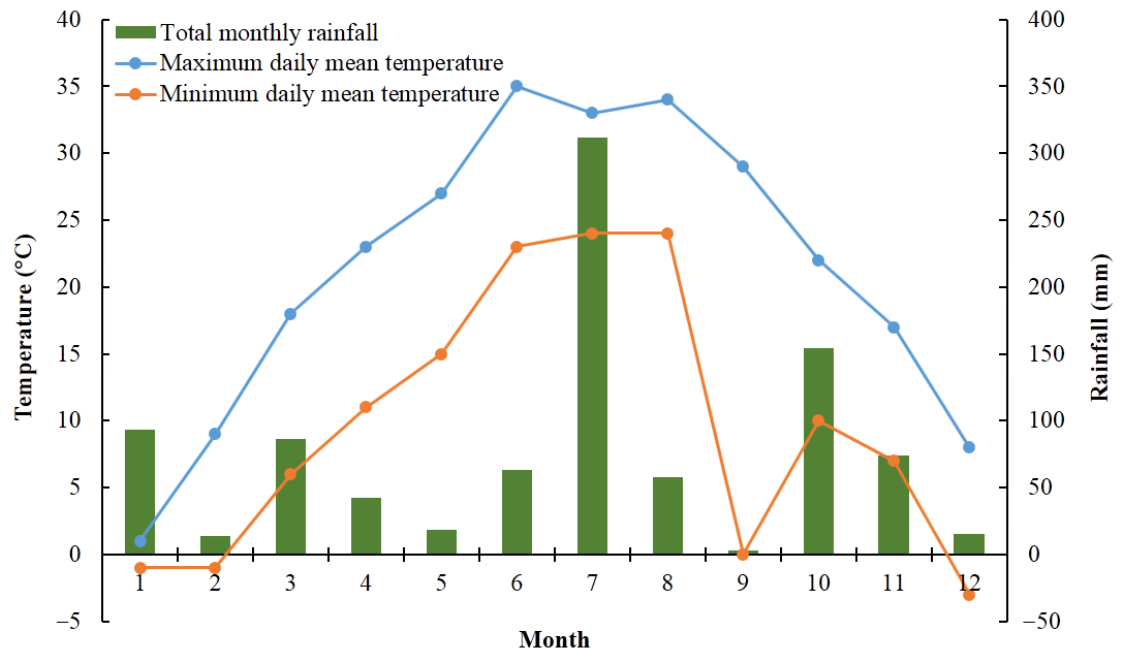
Figure 2. The monthly temperature and rainfall in Zhengyang County. Table 1. Basic soil physiochemical properties and inputs of chemical fertilizers by the farmers’ practice (FP) at different field sites in 2020 and